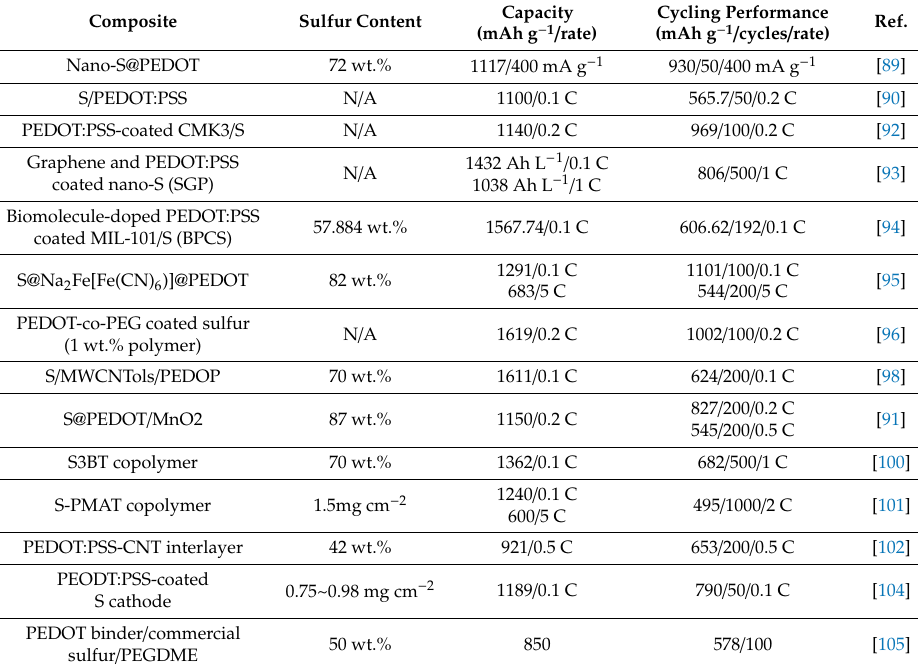
Table 3. The performance of polythiophene-based composites in Li-S